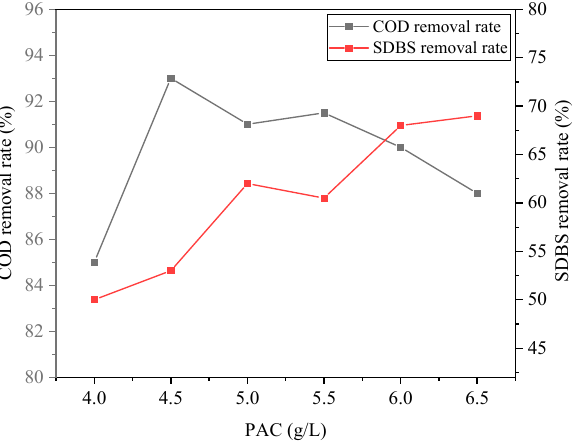
Figure 6. Effect of PAC dosage on removal rates of COD and SDBS.